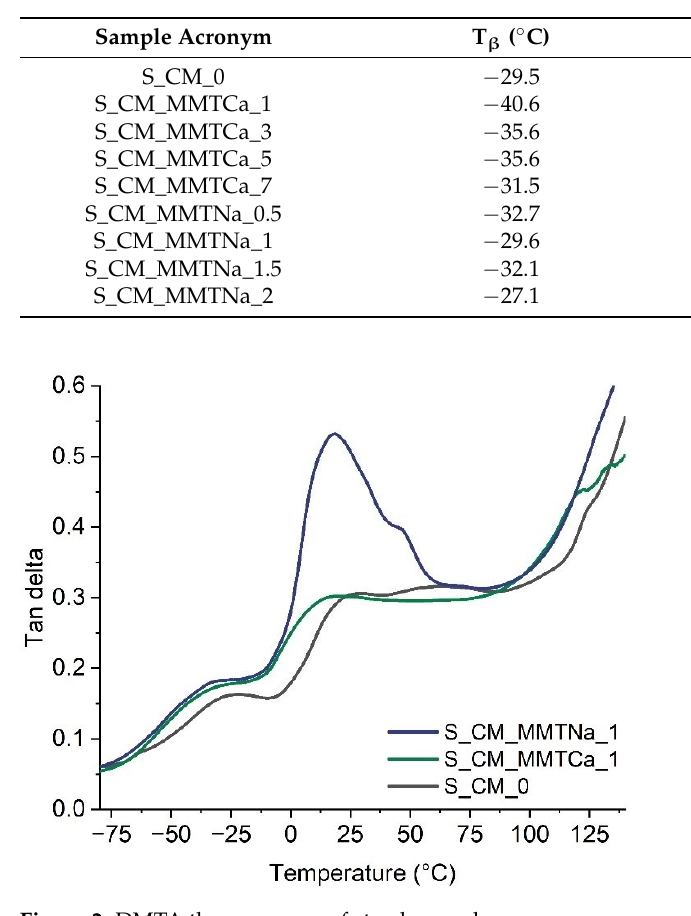
Figure 2. DMTA thermograms of starch